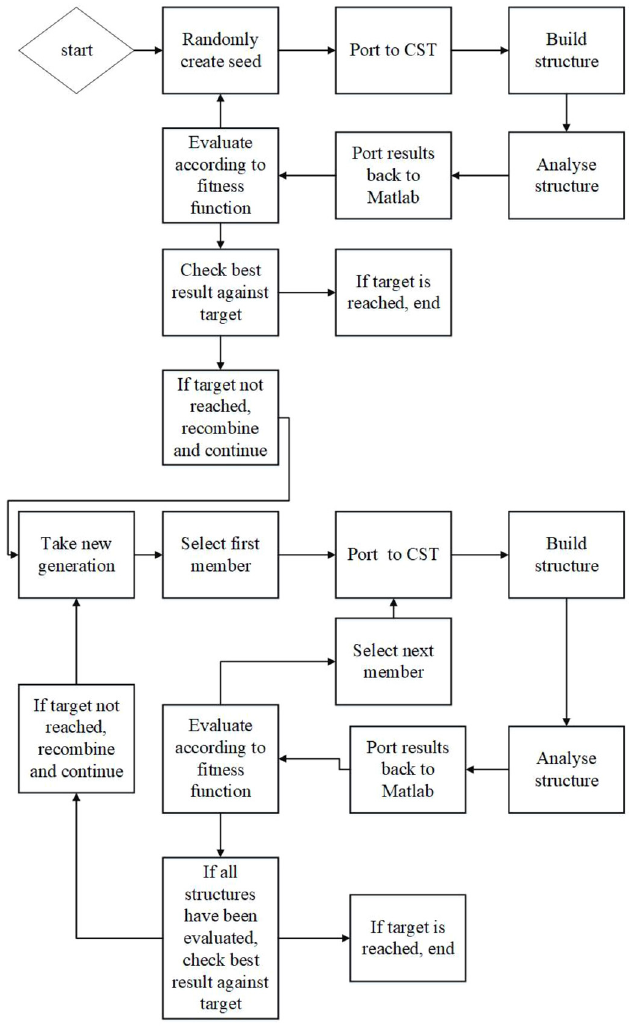
Fig. 2. Flow chart of the genetic algorithm optimization related to the CST studio for the metaferrite